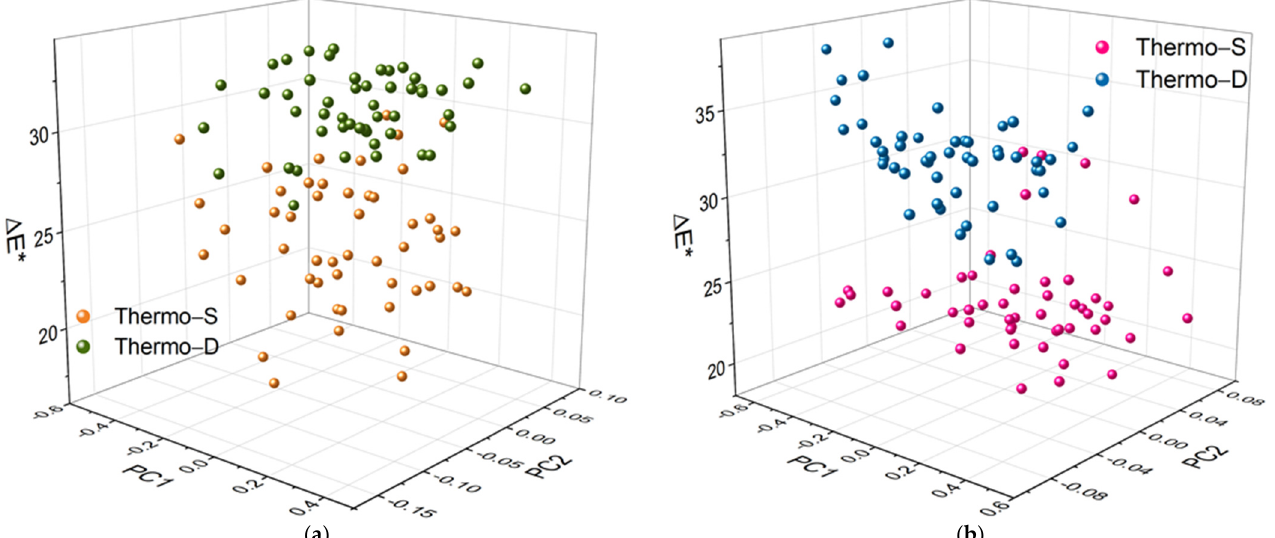
Figure 4. Colour difference ( Δ E*) values plotted as a function of PC1 and PC2 scores for ThermoWood ® Norway spruce ( a ) and Scots pine ( b ).